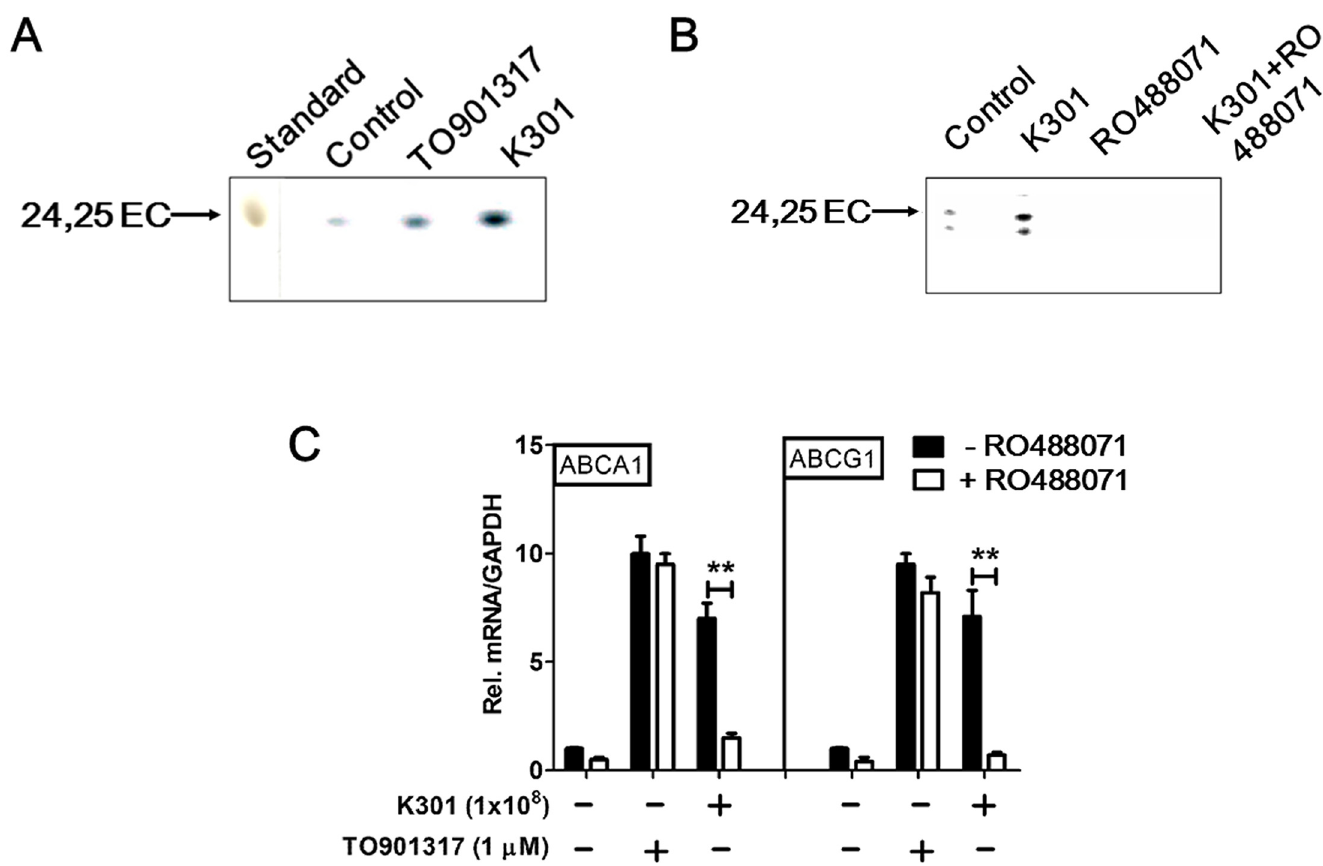
Fig 5. L . acidophilus K301 induced ABCA1 and ABCG1 production through the endogenous LXR agonist, 24( S ), 25-epoxcycholesterol. (A) PMA- differentiated macrophages were incubated with TO901317 and heat-killed L . acidophilus K301 in medium containing [ 14 C]-acetate for 16 h. Neutral lipid extracts were separated by TLC and visualized by exposure to X-ray film. (B) Heat-killed L . acidophilus K301-stimulated THP-1 macrophages were treated with a specific inhibitor of endogenous ligand synthesis, RO 488071, and neutral lipid extracts were separated using TLC. (C) Heat-killed L . acidophilus K301-stimulated THP-1 macrophages were treated with RO 488071 and mRNA levels of ABCA1 and ABCG1 were determined using real-time PCR. mRNA levels were normalized to GAPDH . Data are given as means ± SD. ** P < 0.01 vs. untreated cells. The error bars in individual samples are shown as variations from triplicate